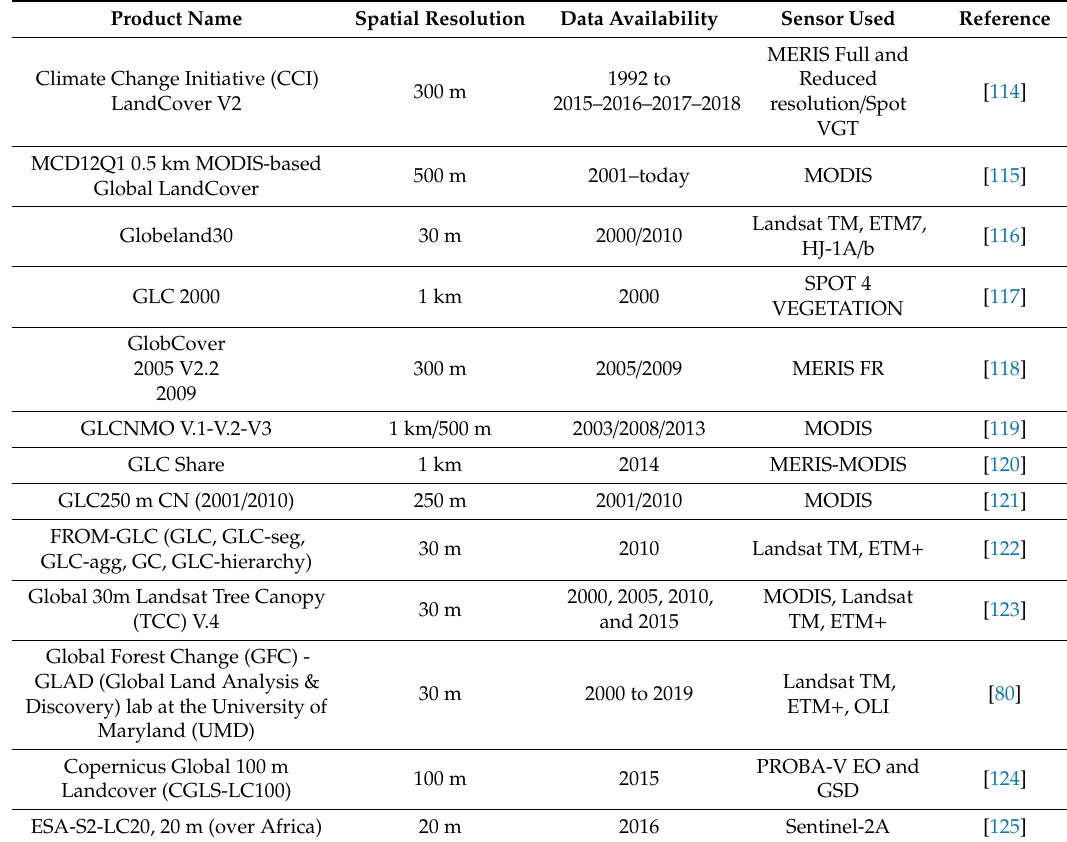
Table 2. List of satellite remote sensing-based landcover